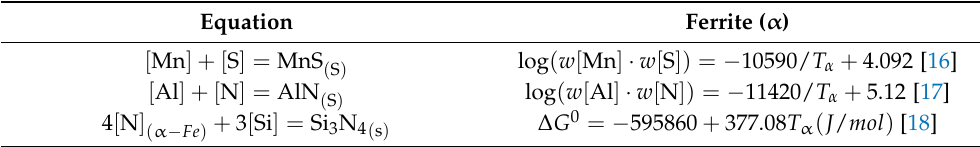
Table 2. Thermodynamics data of MnS, AlN, and Si 3 N 4 in the ferrite steel.